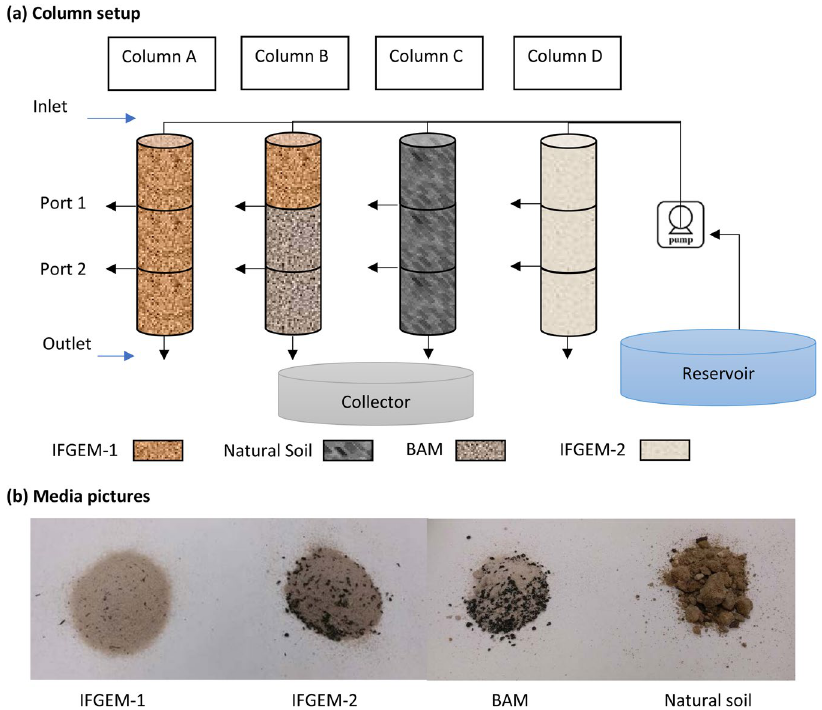
Figure 1. ( a ) diagrams of column setup and ( b ) pictures of media IFGEM-1, IFGEM-2, BAM, and natural